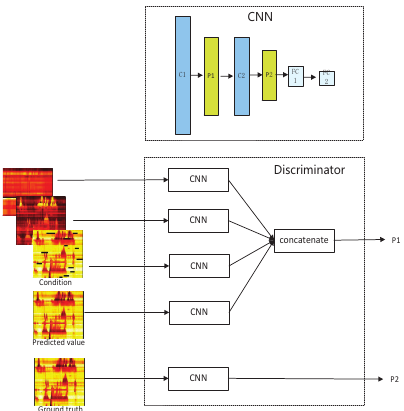
Figure 5. The structure of discriminator of